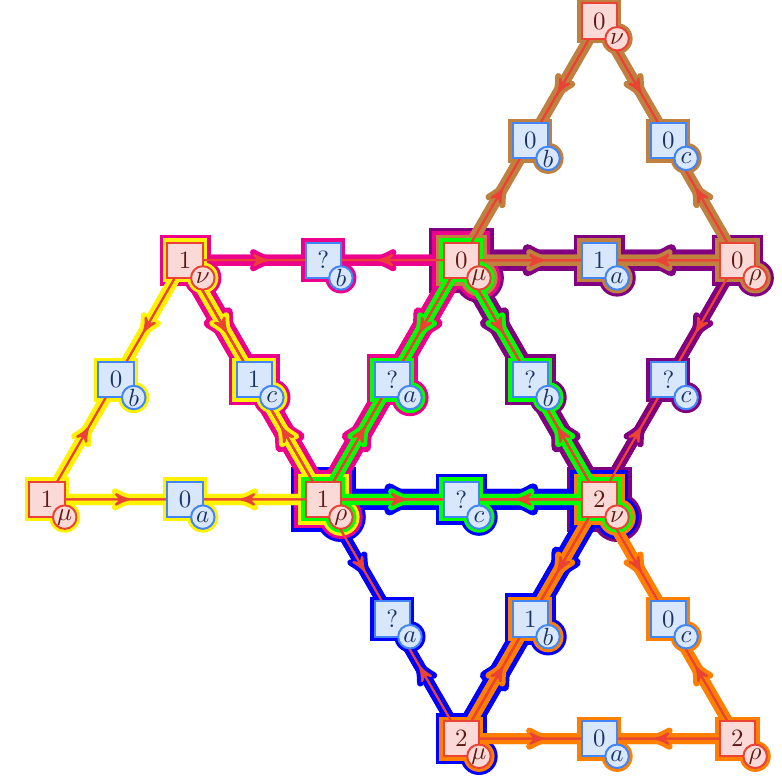
Figure 12: An incomplete possible worlds diagram for the Triangle structure G 11 (Figure 11) initialized by the triplet of observed events in Equation 35. The worlds are colored: wor (0 µ 0 ν 0 ρ ) brown, wor (1 µ 1 ν 1 ρ ) yellow, wor (2 µ 2 ν 2 ρ ) orange, wor (0 µ 1 ν 1 ρ ) magenta, wor (2 µ 2 ν 1 ρ ) blue, wor (0 µ 2 ν 0 ρ ) violet, and wor (0 µ 2 ν 1 ρ ) green.